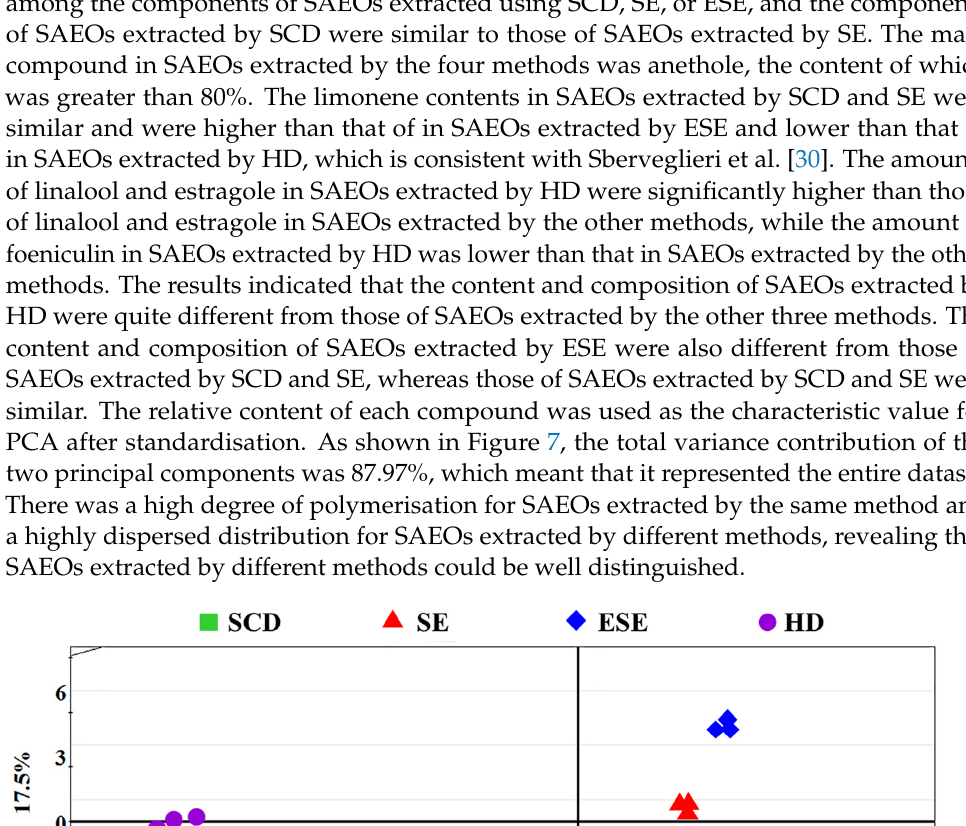
Figure 8. The PCA analysis load diagram of GC − MS of the SAEOs extracted by the four different methods. 4. Conclusions In this study, SAEOs were investigated via E-Nose, GC-MS, and GC-IMS combined with PCA and LDA, and the differences in the SAEO components were also determined. Generally, combining E-nose with PCA could effectively distinguish SAEOs extracted by